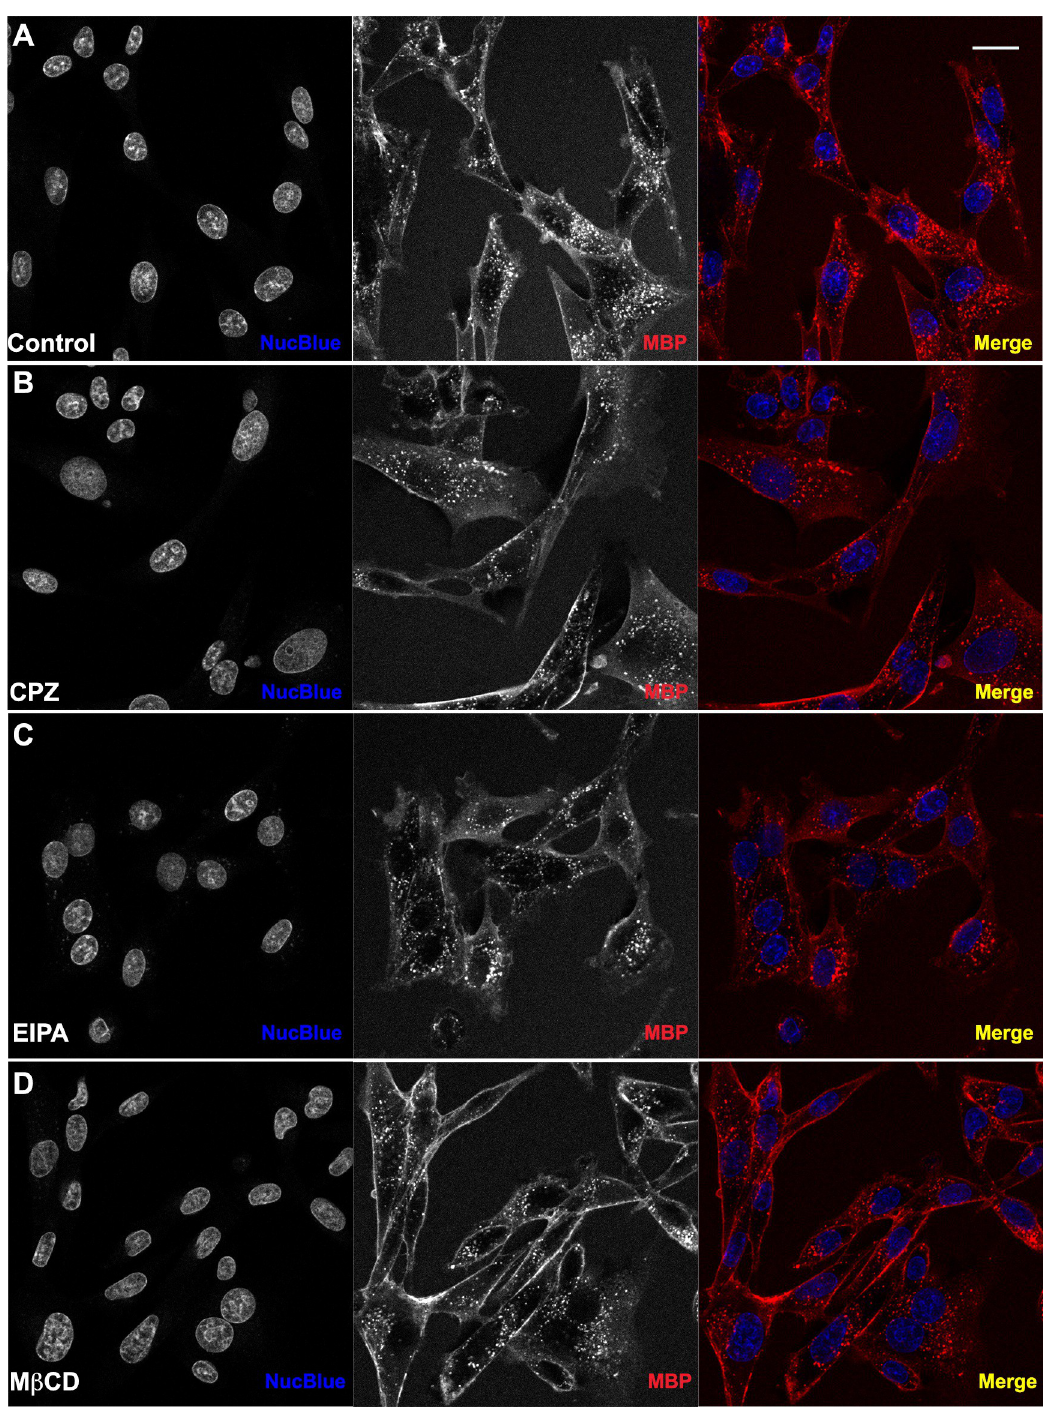
Fig 8. Cell-penetration assays in the presence of inhibitors of endocytosis. WT TAT-NMR-CaM (1uM) and CBS-MBP (1uM) delivered to BHK21 cells in endpoint static assay (N = 3). Cell nuclei (blue) stained with NucBlue and CBS-MBP (red) labeled with DyLight 650. Cells pretreated with inhibitor for 30 minutes. Proteins introduced to cells in presence of inhibitor. (A) No inhibitor. (B) Chlorpromazine Hydrochloride mediated inhibition of CME. (C) Methyl- β -cyclodextrin mediated inhibition of CvME. (D) 5- (N-Ethyl-N-isopropyl) amiloride mediated inhibition of MP. Cells imaged with 40X objective and scale bar = 20 μ m. Red intensity values increased to 45,000 on histogram in Zen Software to improve visualization of uptake.